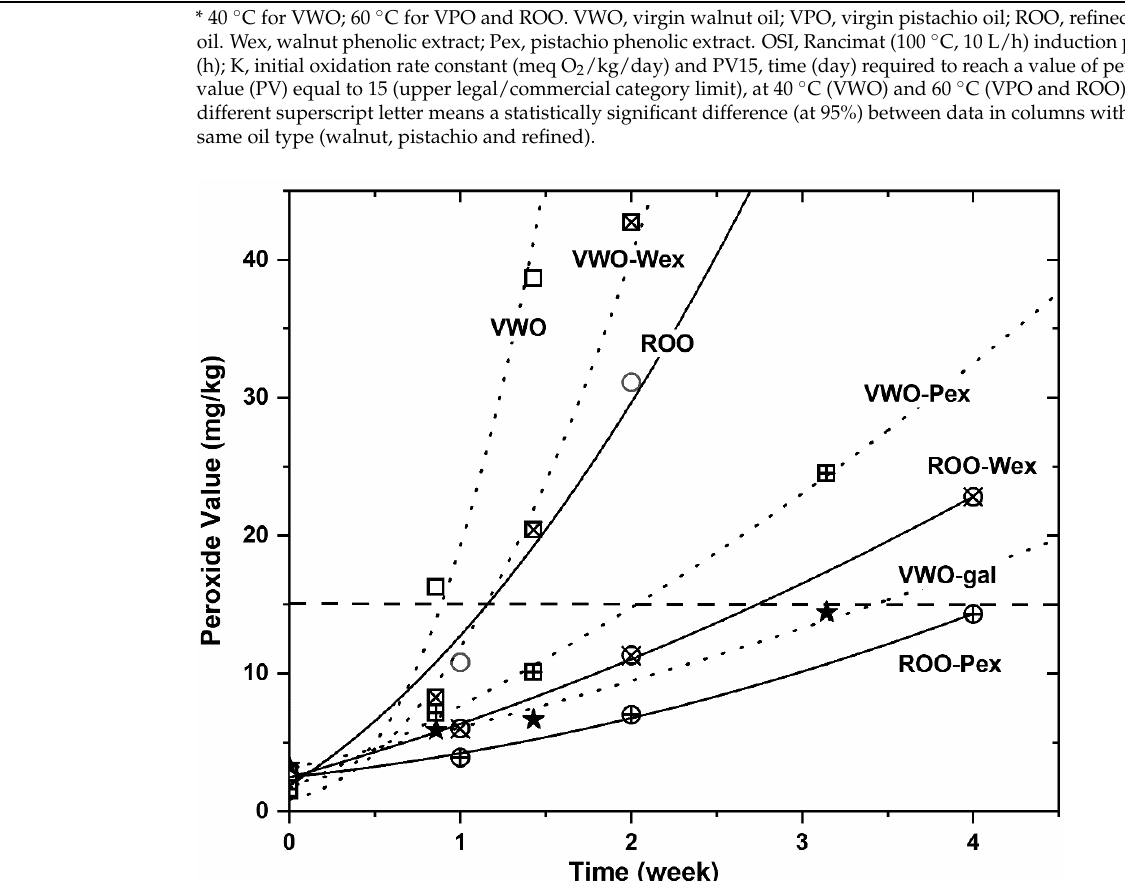
Figure 2. Evolution of the oxidation process of oil formulations under oven test * conditions. Oven Test: 40 °C in VWO; 60 °C in VPO and ROO. VWO, virgin walnut oil; VPO, virgin pistachio oil; ROO, refined olive oil. Wex, walnut phenolic extract; Pex, pistachio phenolic extract; gal, gallic acid. VWO resulted the most sensitive to oxidation (5.3 h of induction period in emulsion and 6.7 h in microemulsions; Table 3), due to its great unsaturated fatty acid proportion (>12% linolenic and >60% linoleic). Its fortification with Wex and Pex greatly improved